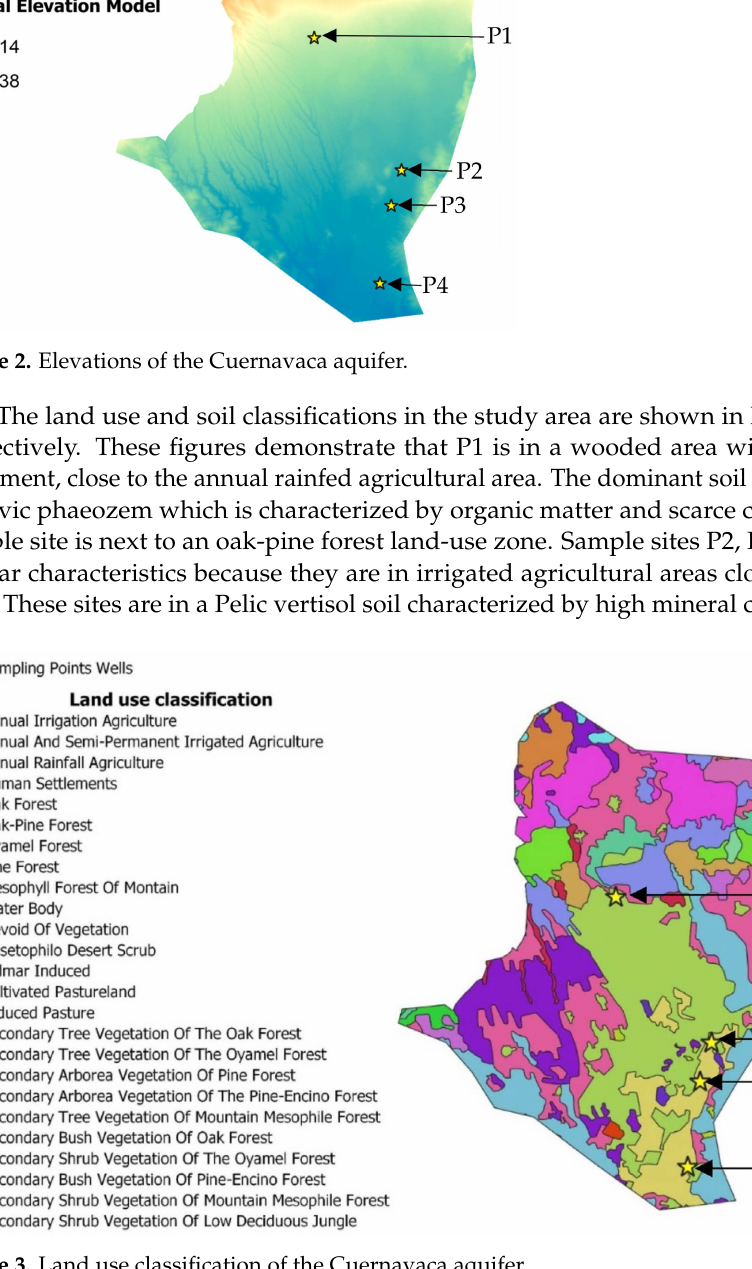
Figure 3. Land use classification of the Cuernavaca